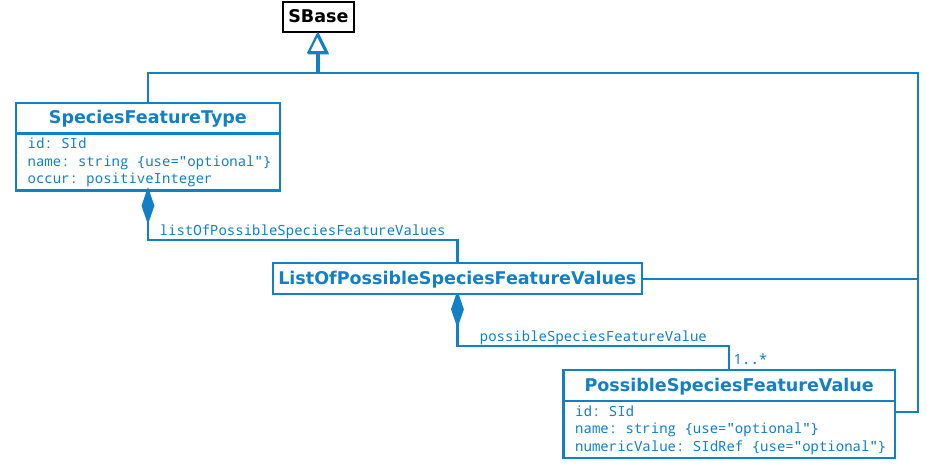
Figure 4: The definitions of SpeciesFeatureType , ListOfPossibleSpeciesFeatureValues and PossibleSpecies- FeatureValue